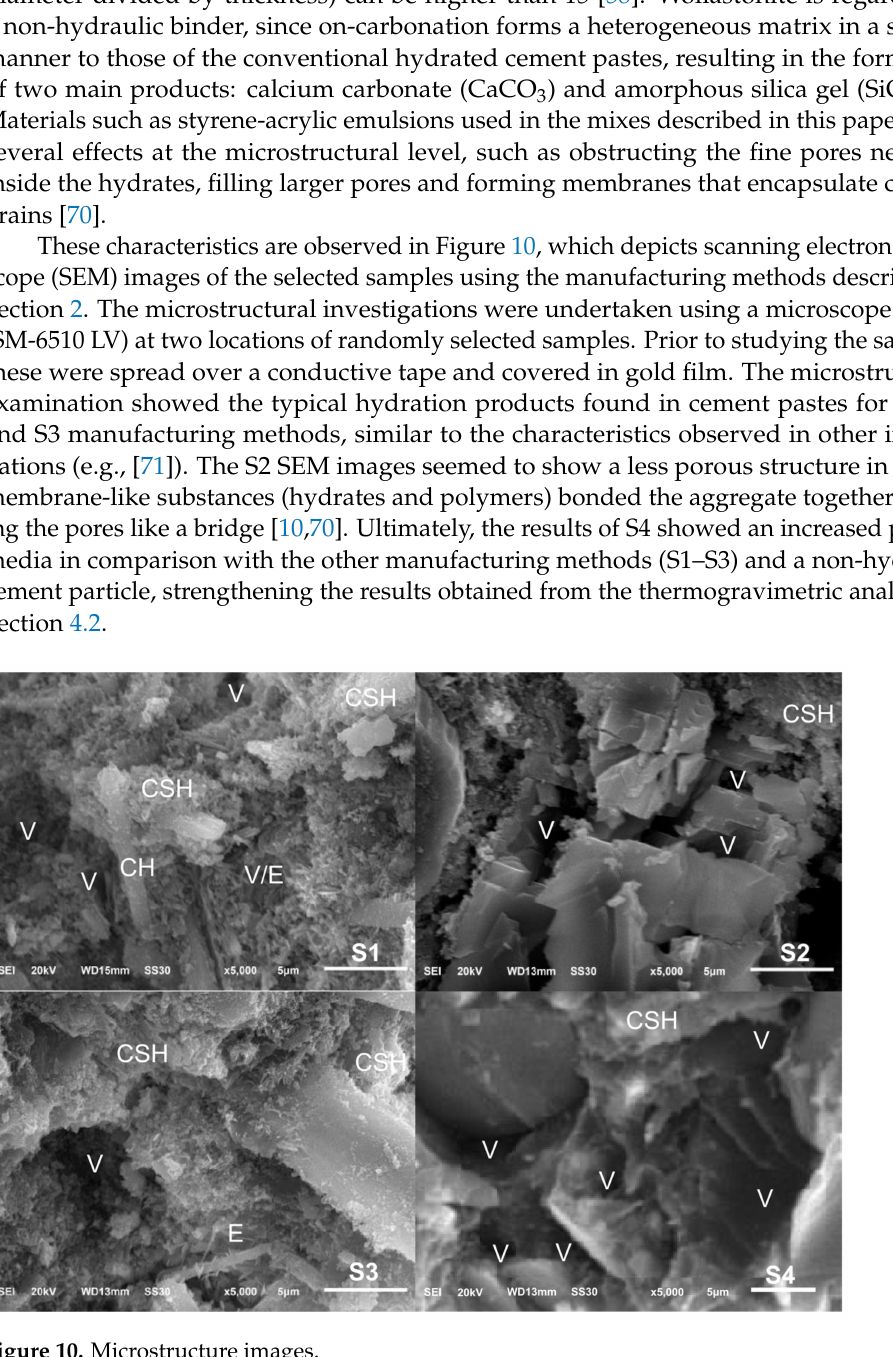
Figure 10. Microstructure